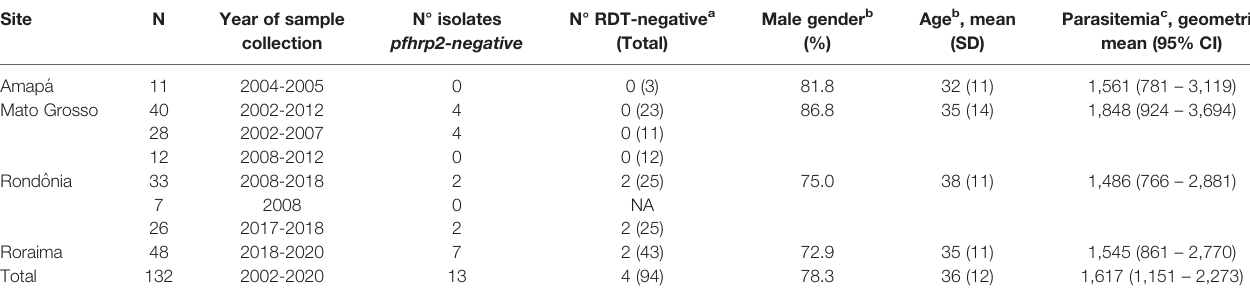
TABLE 1 | Description of 132 Plasmodium falciparum -infected patients enrolled in this study, pfhrp2 deletion pro fi le and RDT